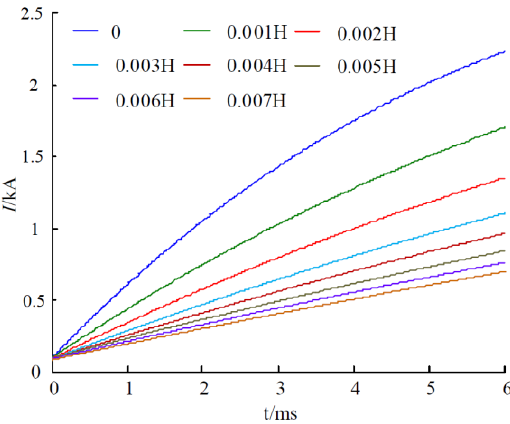
Figure 3. Relationship between fault current and inductance